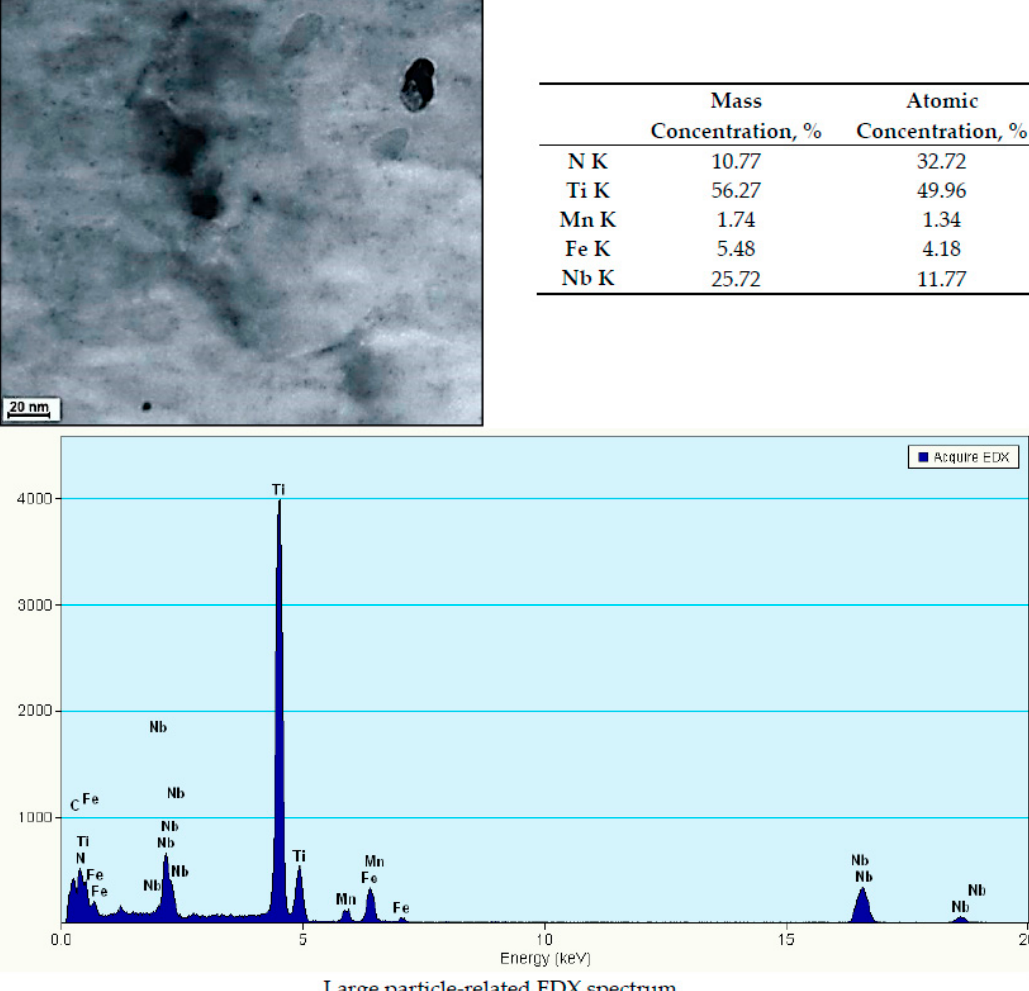
Figure 2. Precipitation of carbonitride (Ti,Nb)(C,N) with numerous small dispersive precipitates corresponding to the hardening of steel.